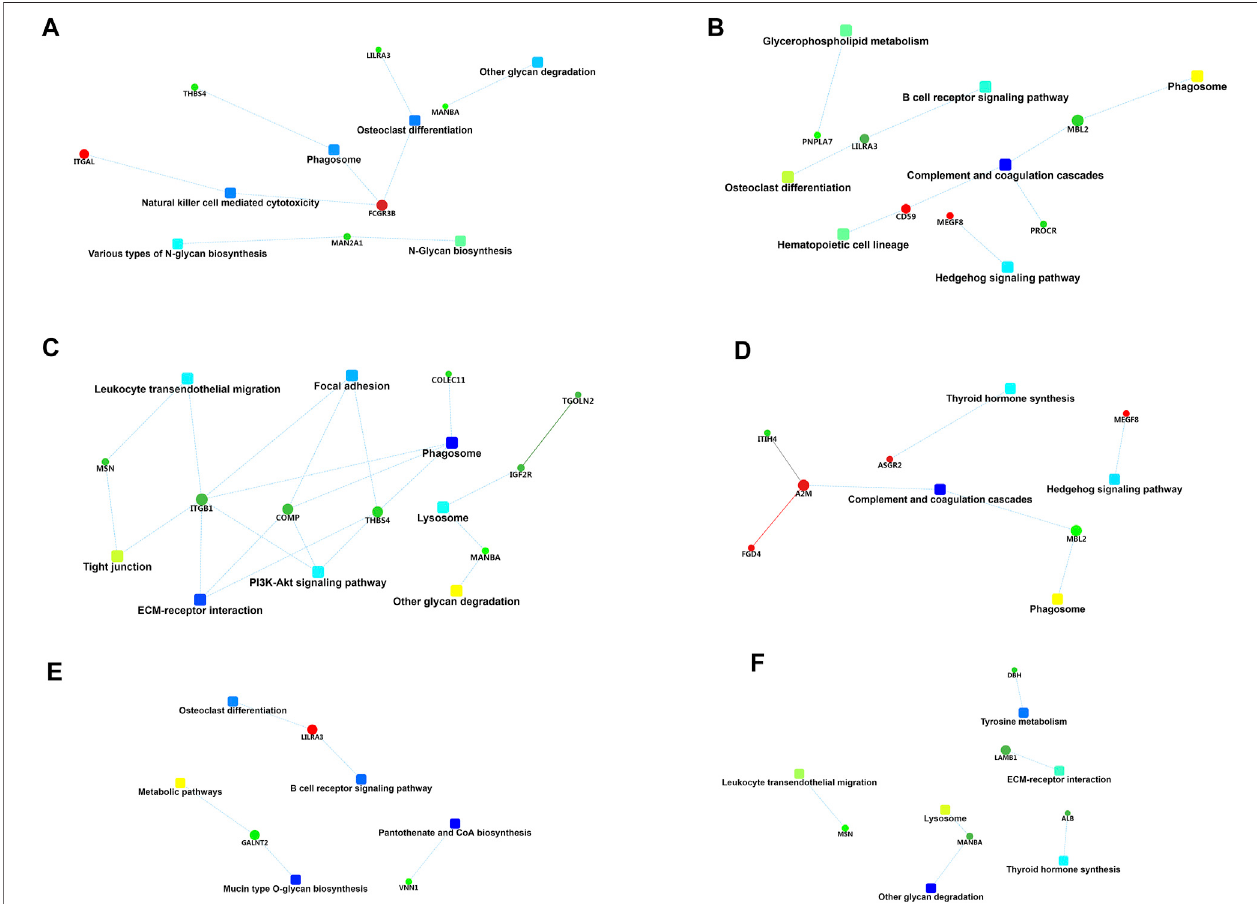
FIGURE 8 | PPI network analysis of differentially expressed proteins: (A) group B (mild OSA) vs group A (non-OSA), (B) group C (moderate OSA) vs group A (non- OSA), (C) group D (severe OSA) vs group A (non-OSA), (D) group C (moderate OSA) vs group B (mild OSA), (E) group D (severe OSA) vs group B (mild OSA), and (F) group D (severe OSA) vs group C (moderate